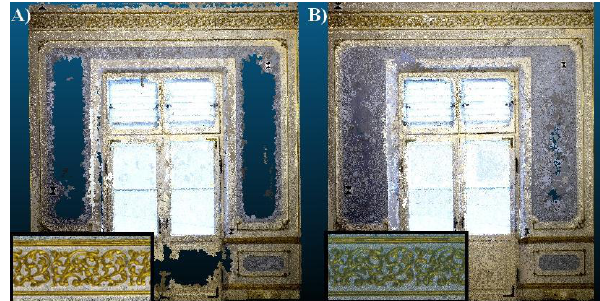
Figure 3. Point cloud generated from image matching and zoomed gilded elements: A) ultrahigh quality; B) high quality. 3.3 Comparison between orthoimages generated from TLS point clouds and dense image-based clouds